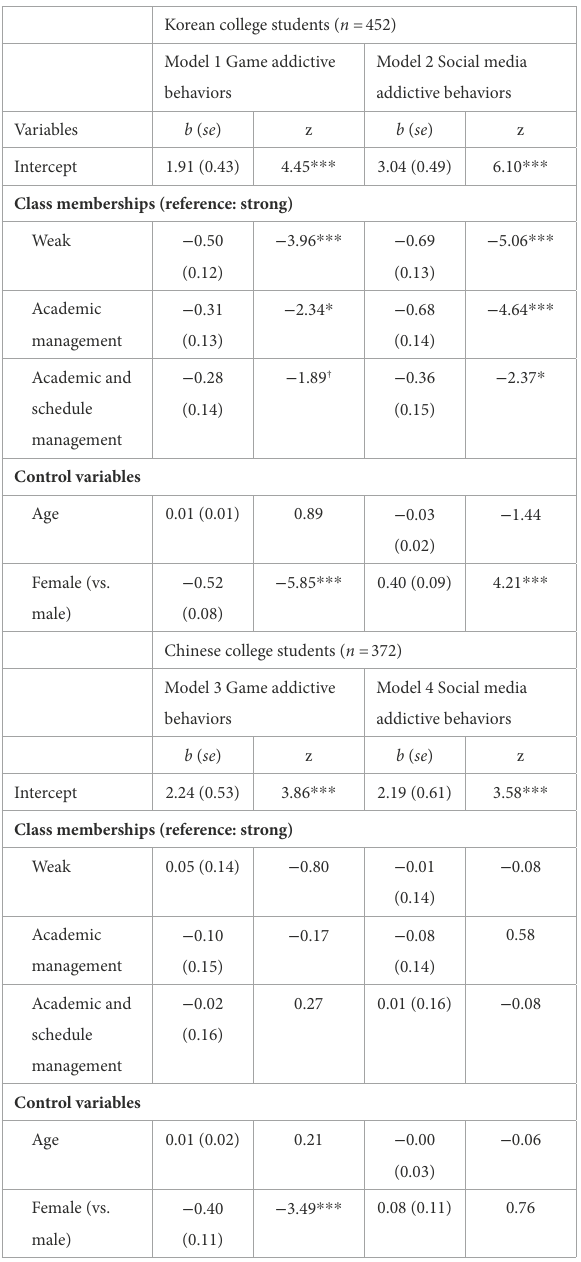
TABLE 4 Associations of helicopter parenting latent class membership with game and social media addictive behaviors. Korean college students ( n =